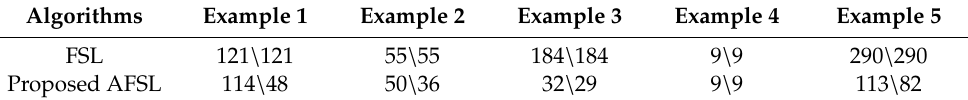
Table 9. Comparisons (i.e., G -evaluations \∇ G -evaluations) of the FSL and AFSL algorithms.